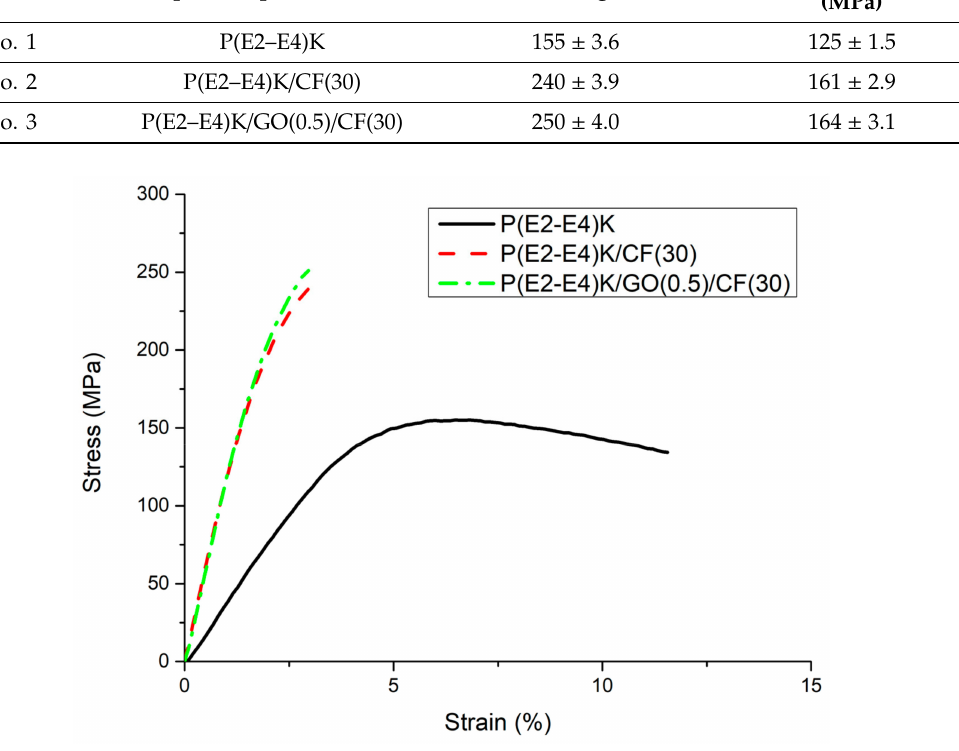
Figure 5. Flexural stress-strain curves of the P(E2–E4)K composite